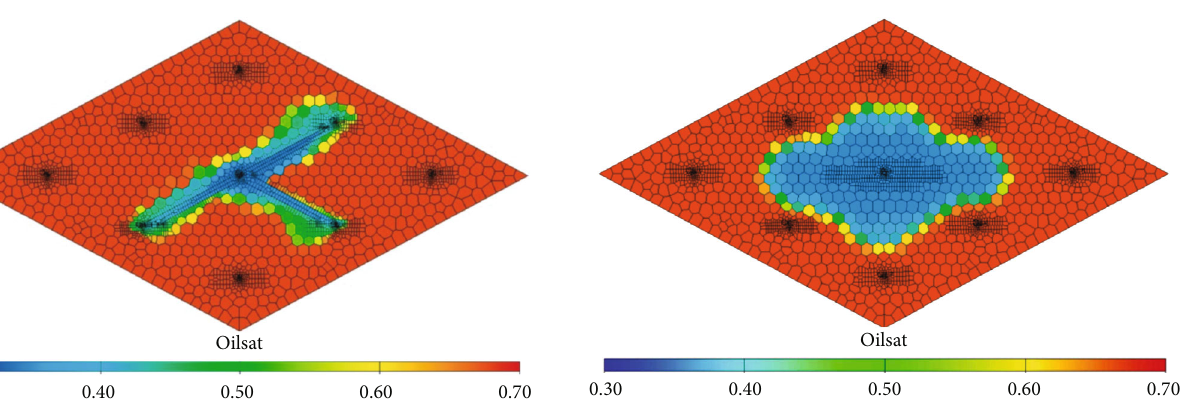
Figure 4: Top view of arti fi cial fracturing in microseismic monitoring of well Y 297-61 of Chang 6 reservoir in Huaqing area.